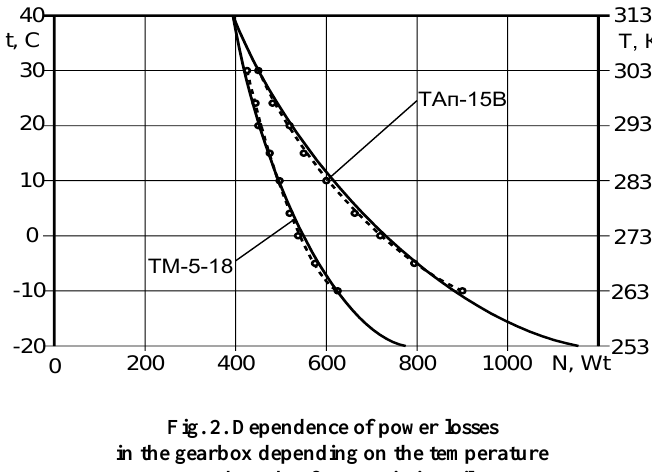
Fig. 2. Dependence of power losses in the gearbox depending on the temperature and grade of transmission